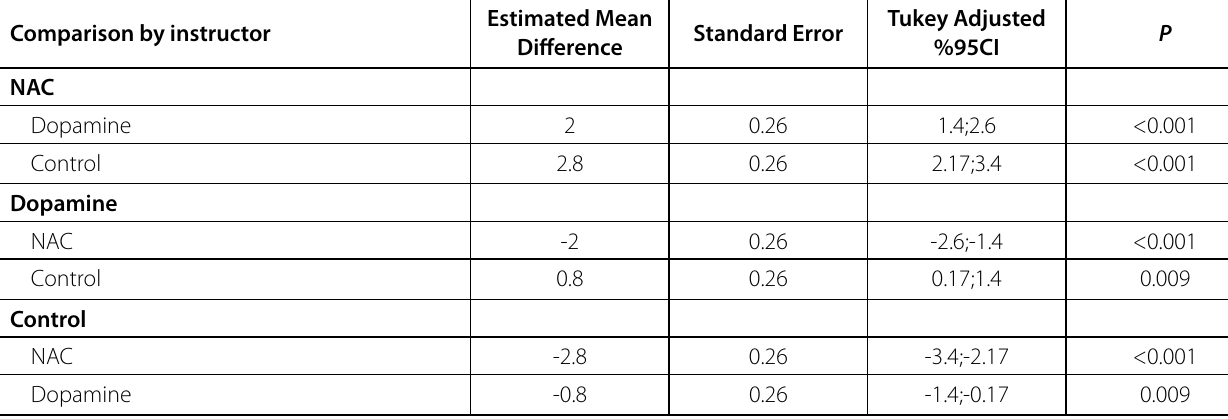
Table 4. Postoperative day 1. Post-hoc evaluation of eGFR with Tukey HSD.